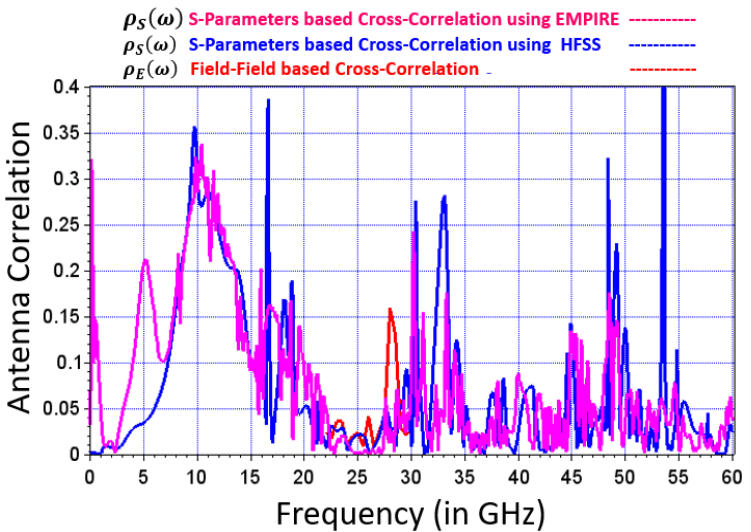
Figure 7. Comparisons between S-parameters port-to-port cross-correlation and field–field cross- correlation as function of frequency.